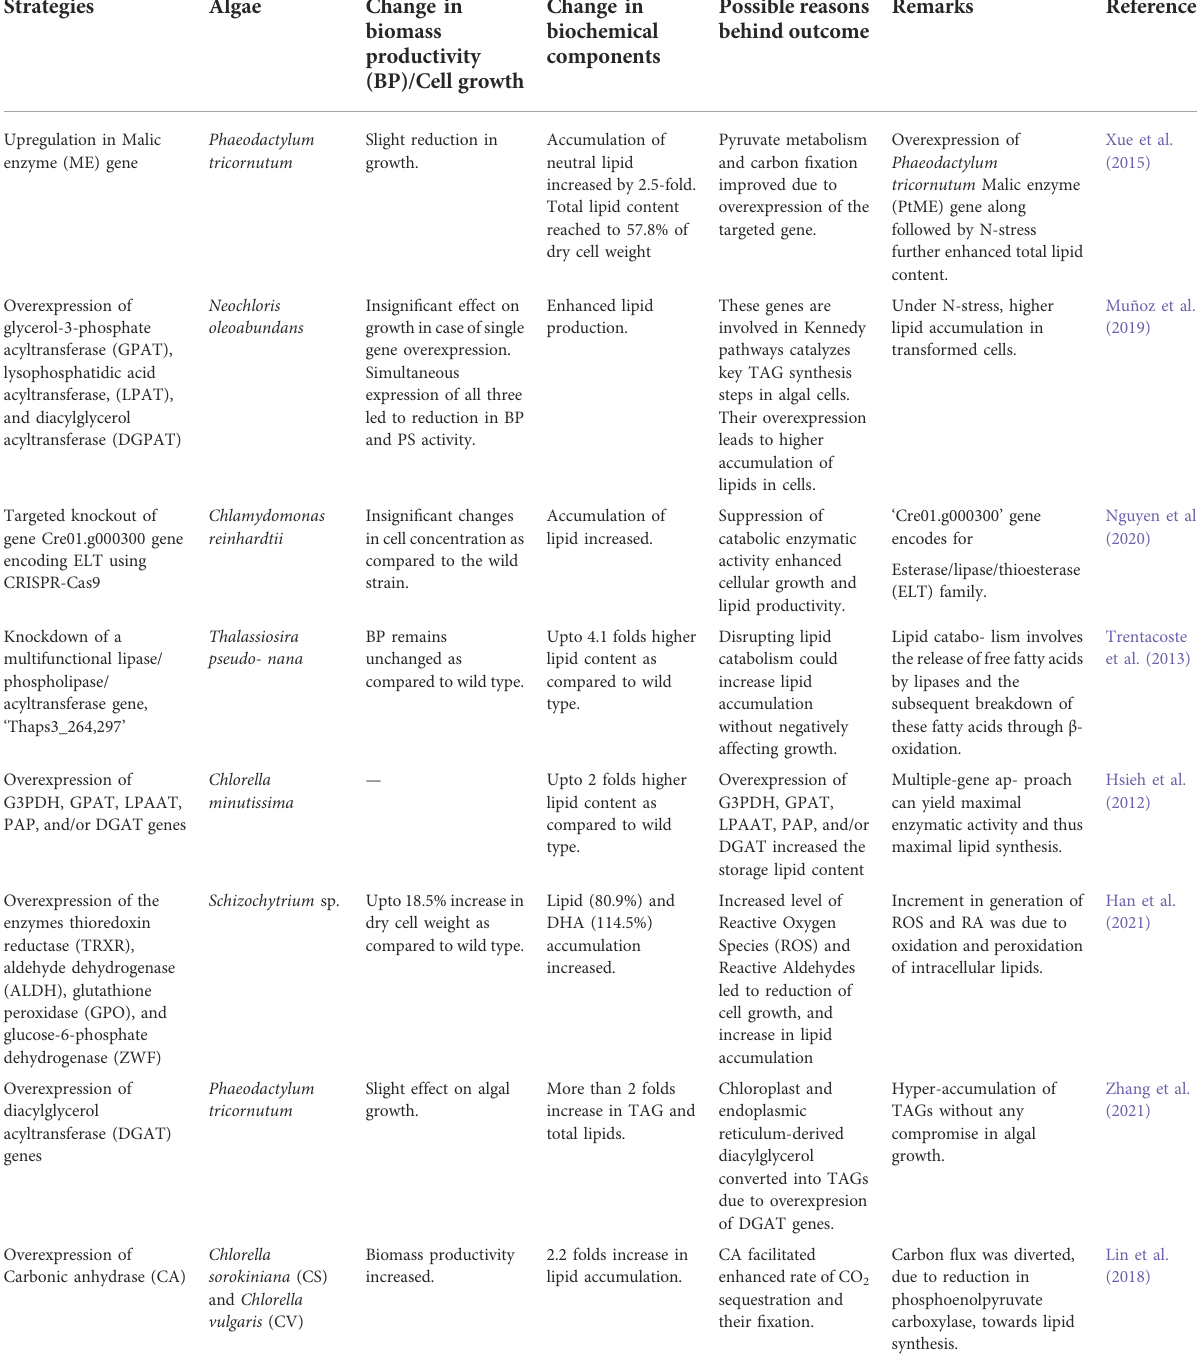
TABLE 3 Genetic engineering strategies to enhance algae